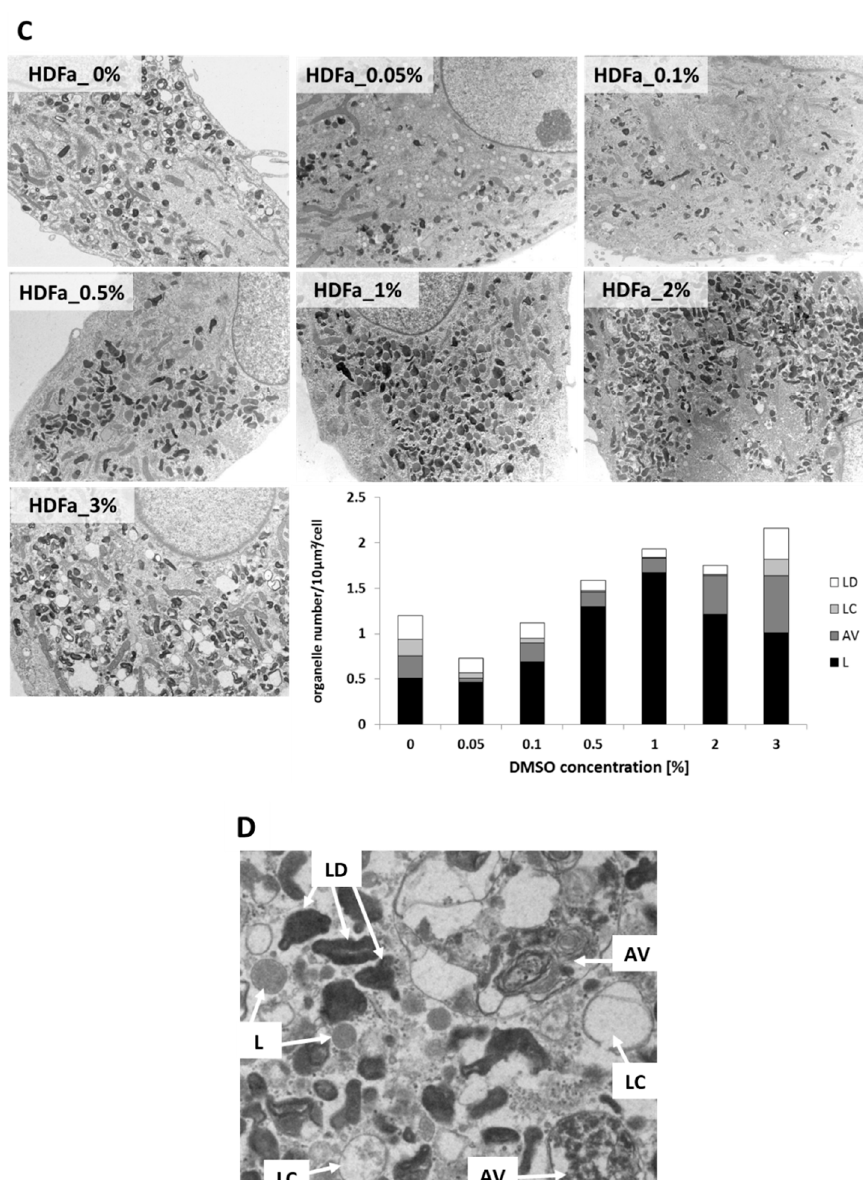
Figure 4. Ultrastructure of MPS III A, B and control (HDFa) fibroblasts (Panels ( A – C ), respectively). Micrographs in TEM after treatment with various DMSO concentrations for 48 h. Images were collected from at least 20 cells with magnification 1650 × . Typical lysosomal structures are presented in panel ( D ). L—lysosome, AV—autophagosomal vacuoles, LC—carbohydrate-storing lysosomes, LD—lysosomes of amorphous flocculent and electron-dense structure.